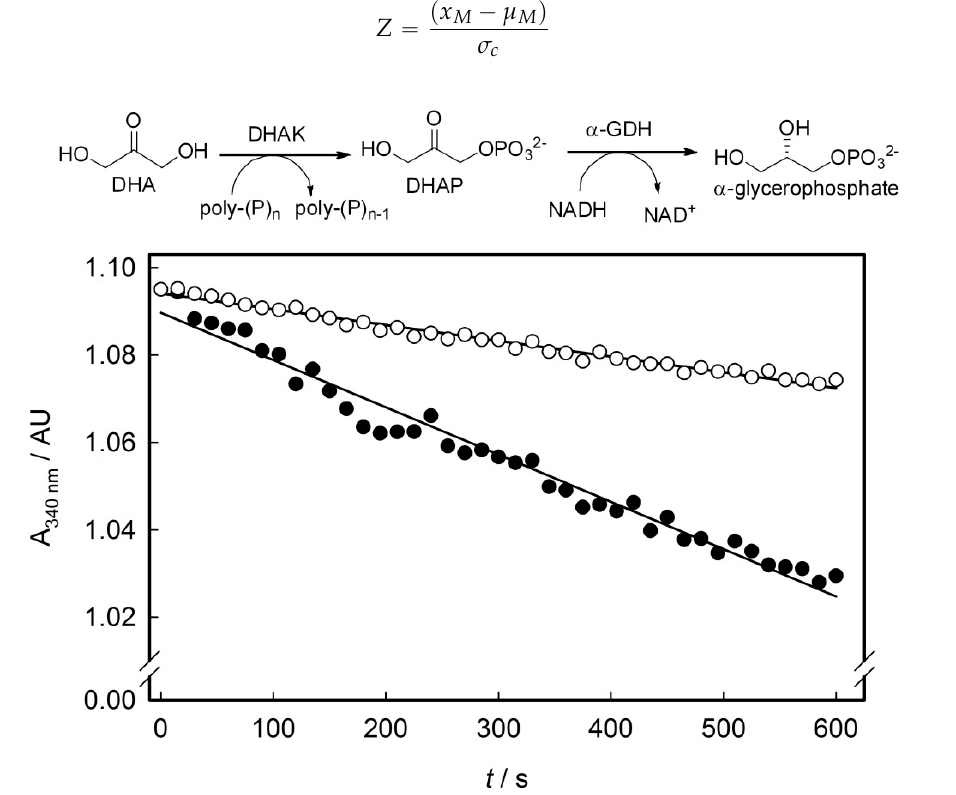
Figure 4. Enzymatic assay used to evaluate the poly-P-dependent kinase activity in the DHAK mutant library and time-dependent decrease of NADH absorbance at 340 nm corresponding to the mutant 3E4. ( ) Unspecific NADH oxidation measured in absence of DHA and ( ) slope obtained in presence of DHA. For details, see Section 3.6.